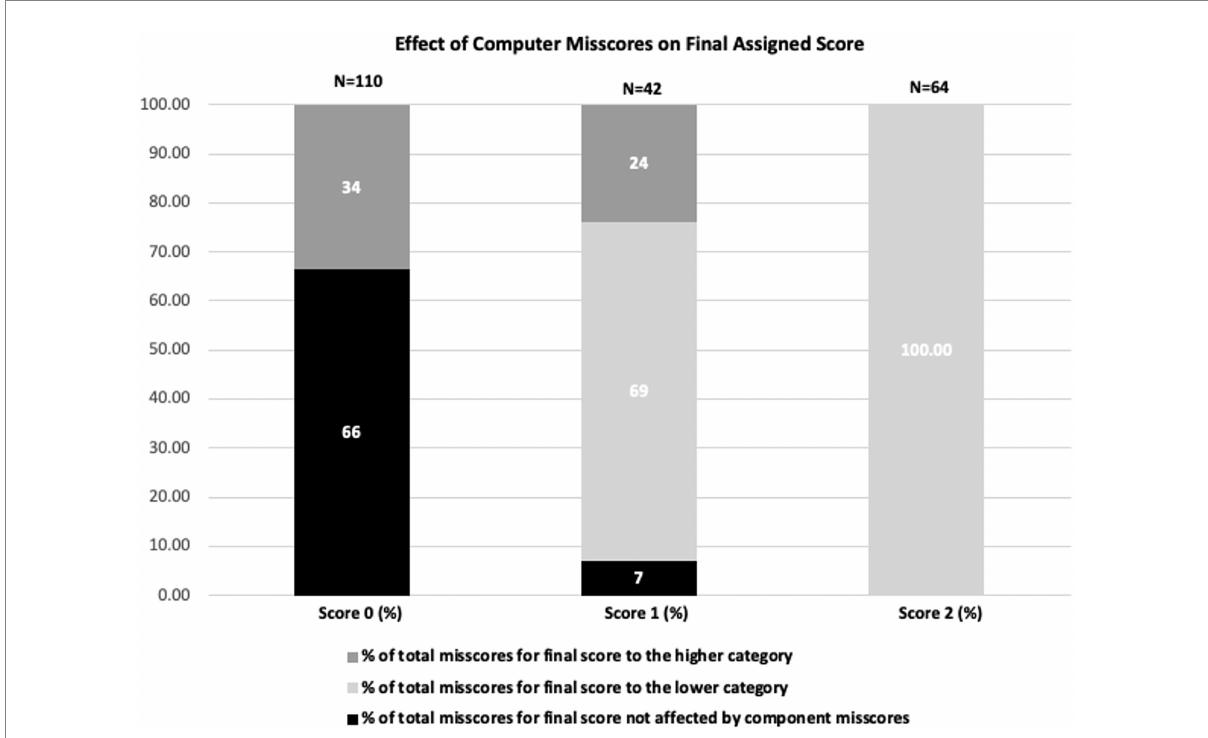
FIGURE 9 Effect of MA component misscores on final assigned score for